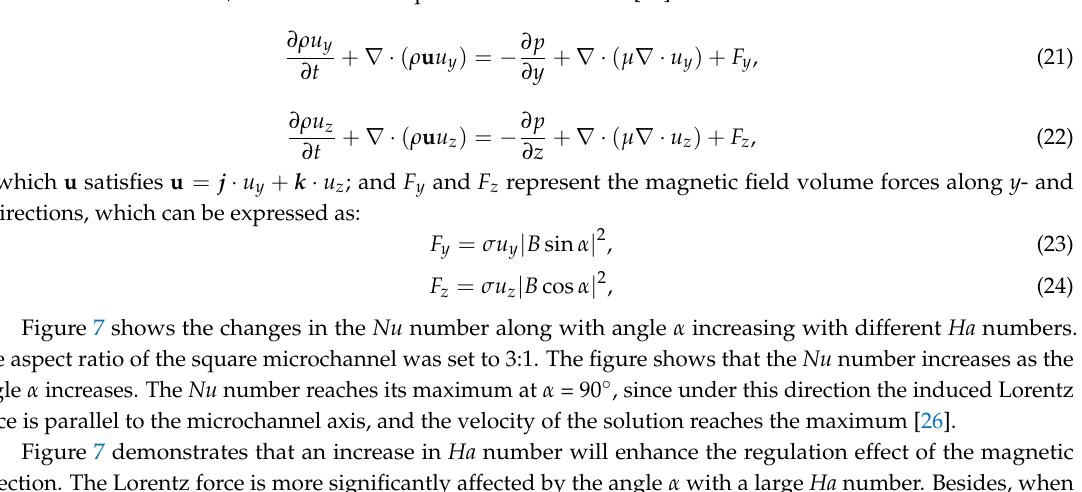
Figure 6. Two-dimensional cross-section of a microchannel that changes the magnetic field angle.